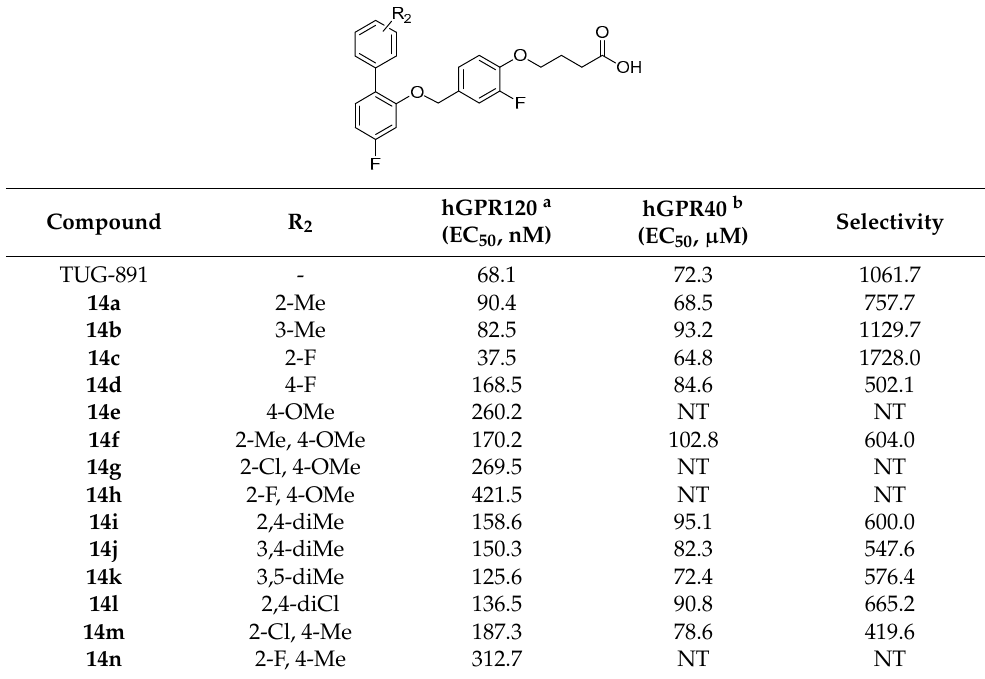
Table 2. In vitro activities and selectivity of target compounds 14a – 14n .